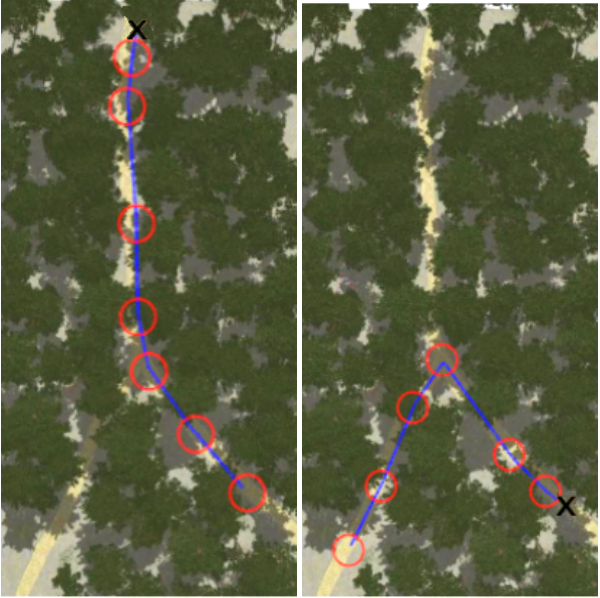
Figure 10. Paths followed during data acquisition in the forest environment.